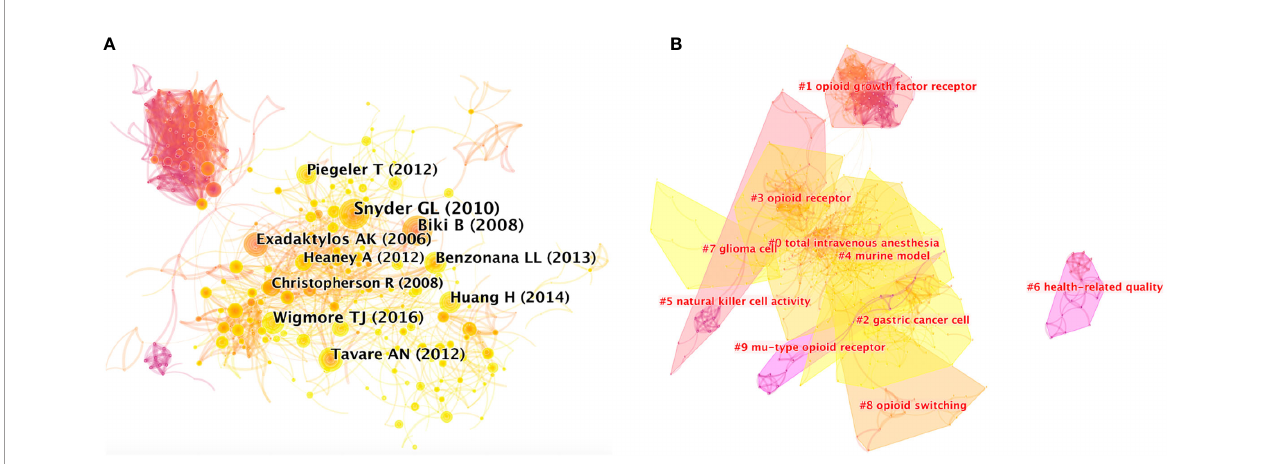
FIGURE 4 | (A) Citespce co-citation map of 36072 references on anesthesia and cancer research, fi lter option showing the largest connected component only. Each circle represents a reference. Size of circle is positively correlated with frequency of citations, and links between two circles represent two references that were cited in the same article. Year and fi rst author of the top 10 most cited publications are shown. Timespan: 2001-2020; Slice length = 1. (B) Clustered networks of co-citation status of the investigated 36072 references and the 1494 citing articles via CiteSpace. The top 10 largest clusters of citing articles are shown.